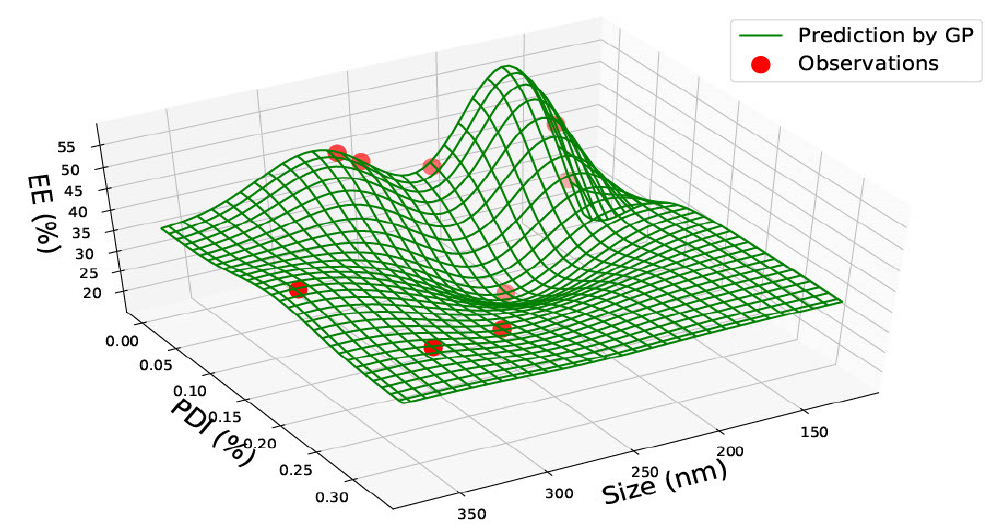
Figure 5. PLGA 65:35—graph with size (nm), Polydispersity Index (PDI) and Encapsulation Efficiency (EE%).